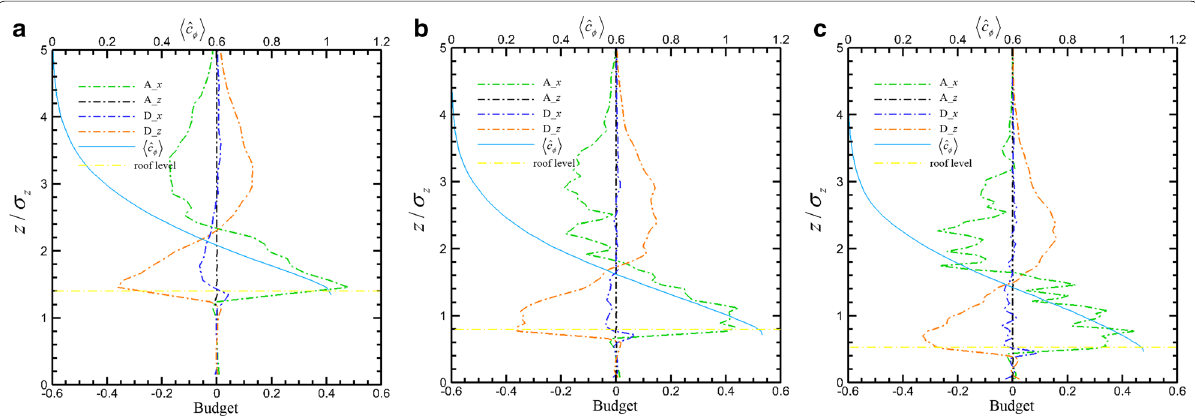
Fig. 3 Budget analysis and vertical profiles of passive scalar concentration in the streamwise direction at a x / h